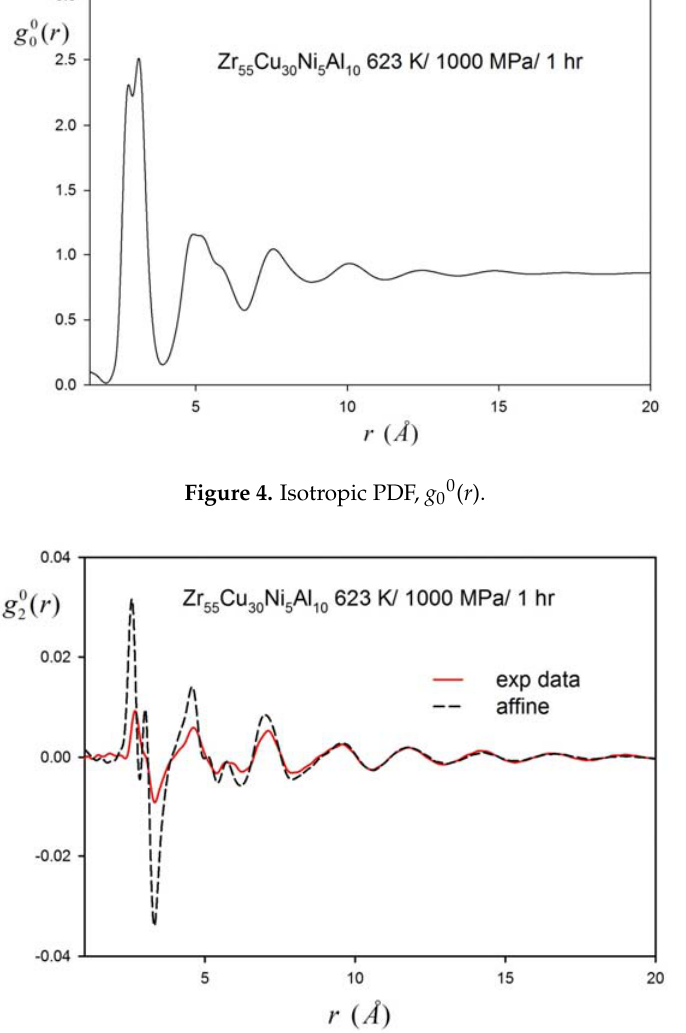
S Q . S Q . p Q q . Figure 3. Anisotropic structure function S 2 0 ( Q ) . Line in pink shows   0 2, affine 2, affine S Q . 2, af fine 2, affine